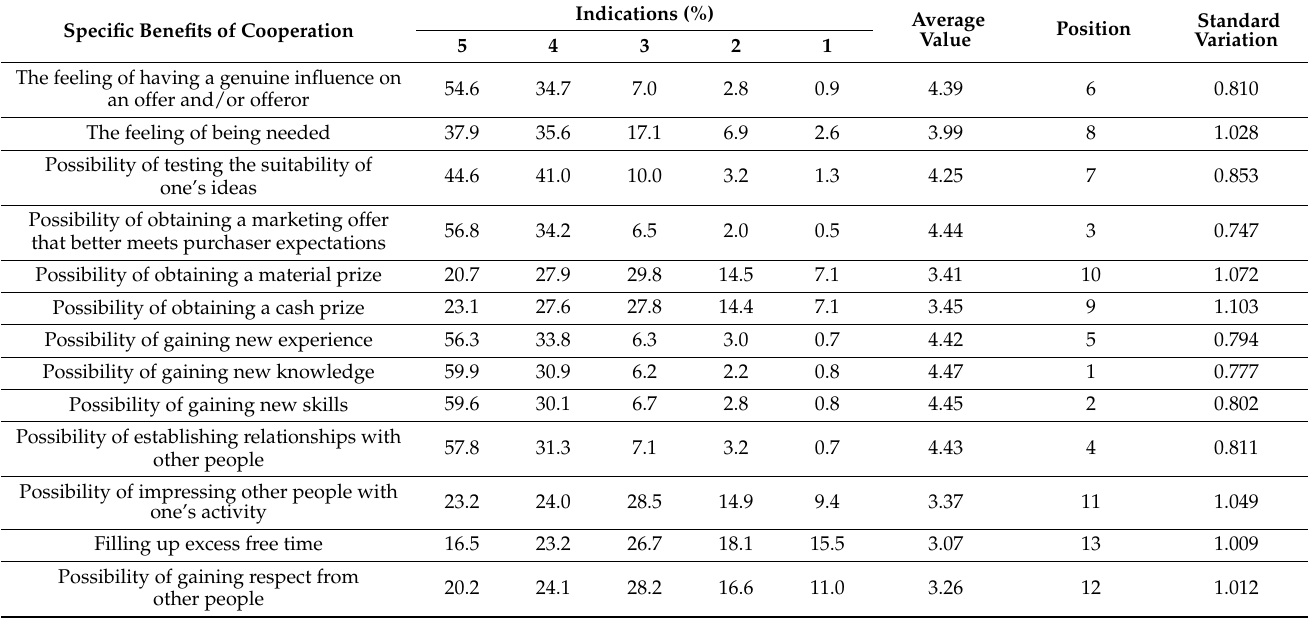
Table 4. Specific benefits indicated by respondents that are achieved by a final purchaser thanks to cooperation with offerors during the preparation of marketing